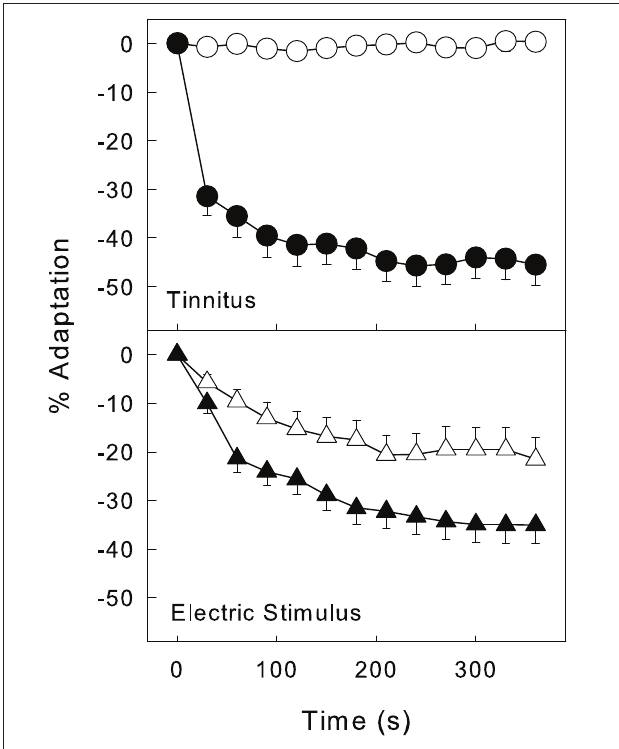
FIGURE 5 | Adaptation of tinnitus and electric stimuli, Responders versus Non-Responders. Tinnitus adaptation is shown across time in the top panel, averaged across Responder (filled circles) and Non-Responder subjects (open circles). Electric stimuli adaptation is shown across time in the bottom panel, averaged across Responder (filled triangles) and Non-Responder subjects (open triangles). Error bars indicate